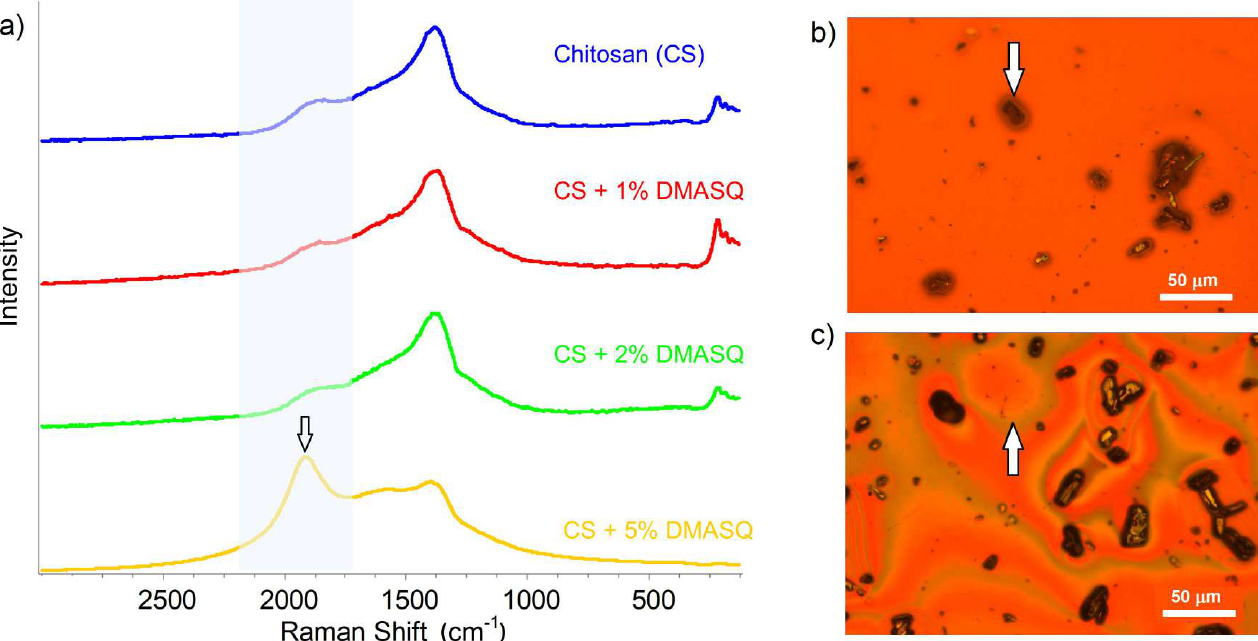
Figure 6. Raman spectra ( a ) of CS and CS containing 1–5% DMASQ films in 2500–500 cm − 1 range (the shaded part indicates a band with a maximum at 1910 cm − 1 from DMASQ); microscopic image of CS + 2% DMASQ ( b ) and CS + 5% DMASQ ( c ) where the arrow points to the interphase